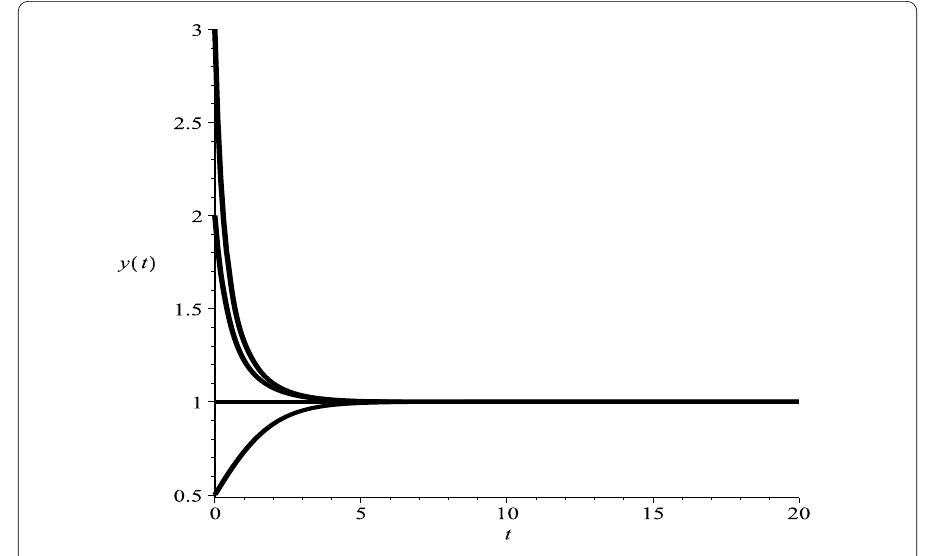
Figure 4 Dynamics behavior of the third component y ( t ) of system (5.1); here we take k = 0.9 and the initial conditions ( x